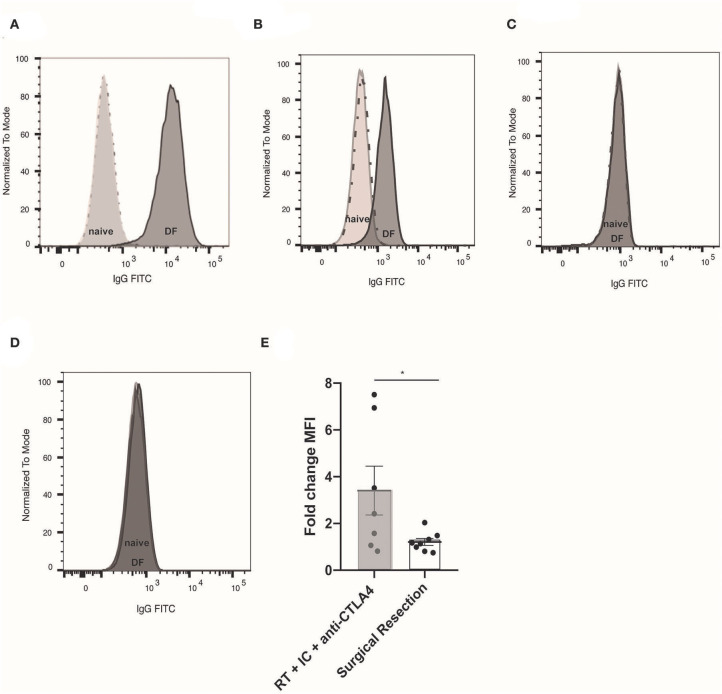
Tumor specific, adaptive humoral response observed after RT + IT-IC + anti-CTLA-4. (A) Flow cytometry histogram of B78 cells (unlabeled cells represented by dotted line) labeled with naïve serum (light gray) from a non-tumor bearing, untreated mouse, or serum from a mouse rendered disease free (DF) following RT + IC + anti-CTLA4 (dark gray). Serum was collected 10 days after 2 million B78 tumor cell were implanted by subcutaneous injection to the right flank of mice previously rendered DF of B78 tumors following RT + IC + anti-CTLA4. Unlabeled B78 cells and naïve serum labeled cells appear superimposed due to low naïve serum binding activity. (B) Flow cytometry histogram of cells only (dotted line), naïve serum (light gray), and RT + IC + anti-CTLA4 DF rendered serum (dark gray) binding to B16 (GD2-) melanoma; (C) Binding to PancO2 (GD2+) pancreatic cancer; and (D) Binding to PancO2 (GD2-), pancreatic cancer. In (C,D), histogram of cells only (dotted line), and the histograms representing serum labeled cells appear superimposed due to serum binding activity being comparable to the background with no serum. (E) Fold change Median fluorescence intensity (MFI) of endogenous anti-tumor antibody from individual mice bound to B16 (GD2-) melanoma, representing change from pre-re-challenge to 10 days after re-challenge. Serum was obtained from mice rendered DF by RT + IC + anti-CTLA4 (gray box) or surgical resection (white box) prior to 2 million B78 melanoma tumor cell re-challenge (pre-re-challenge), or 10 days after re-challenge (post-re-challenge). Data in (A–D) represent one of three replicates; data in (E) is composite data from two replicate studies. *p < 0.05.